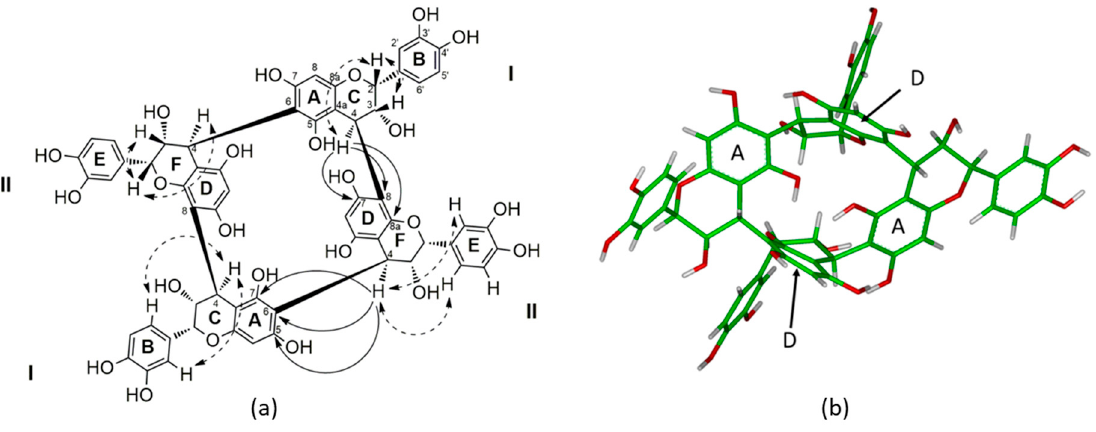
Figure 1. ( a ) Structure of the crown tetramer ( 1 ) with the key HMBC correlation (H → C, full arrow) and main ROESY correlation for the II units (dotted double arrow). Similar ROESY correlations were also observed for the I units. ( b ) 3D model of the crown procyadnidin tetramer ( 1 ) on the basis of NMR spectroscopic data and NMR restrained molecular modeling.